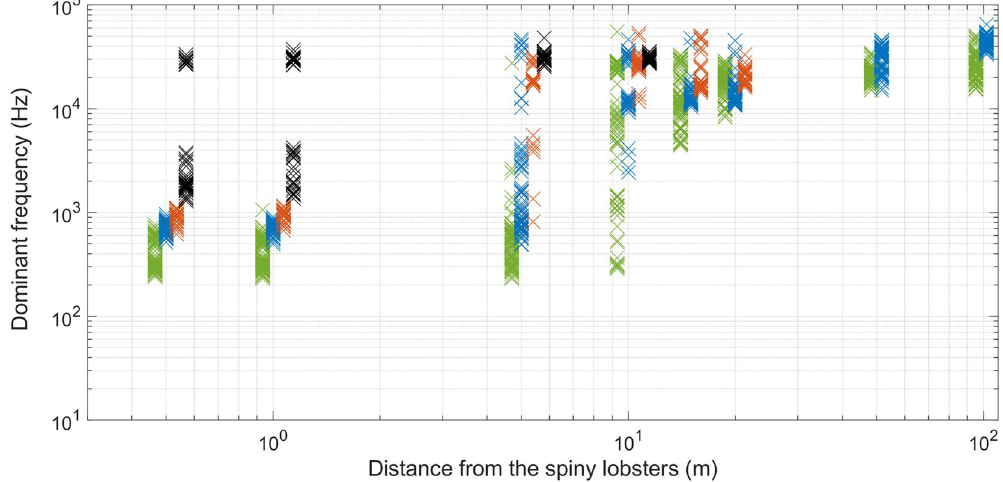
Figure 3. Dominant frequencies calculated on the recorded antennal rasps as a function of the animal- hydrophone distance. Each point represents the value from one antennal rasp. The colors are related to the body size of the spiny lobsters (green: large, blue: intermediate, orange: small, black: very small). Both x- and y-axis are in logarithmic